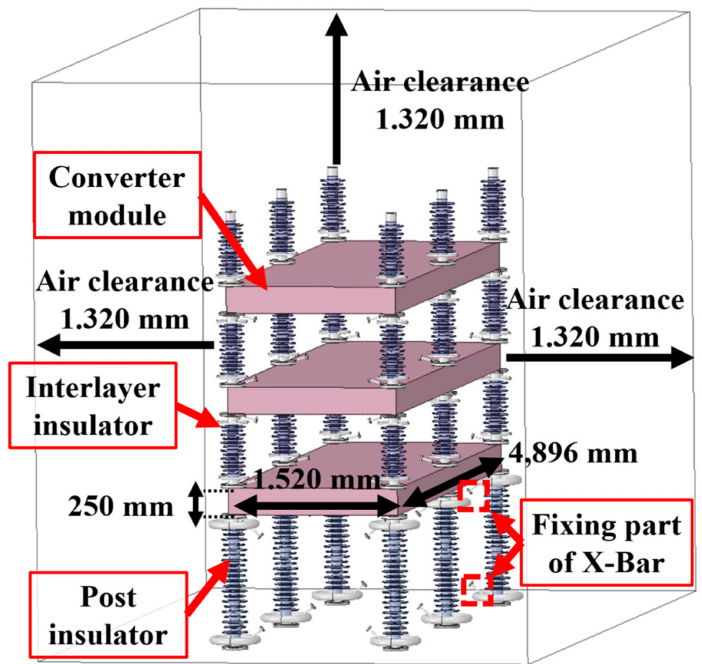
Figure 12. Base model for the DC corona shield design.